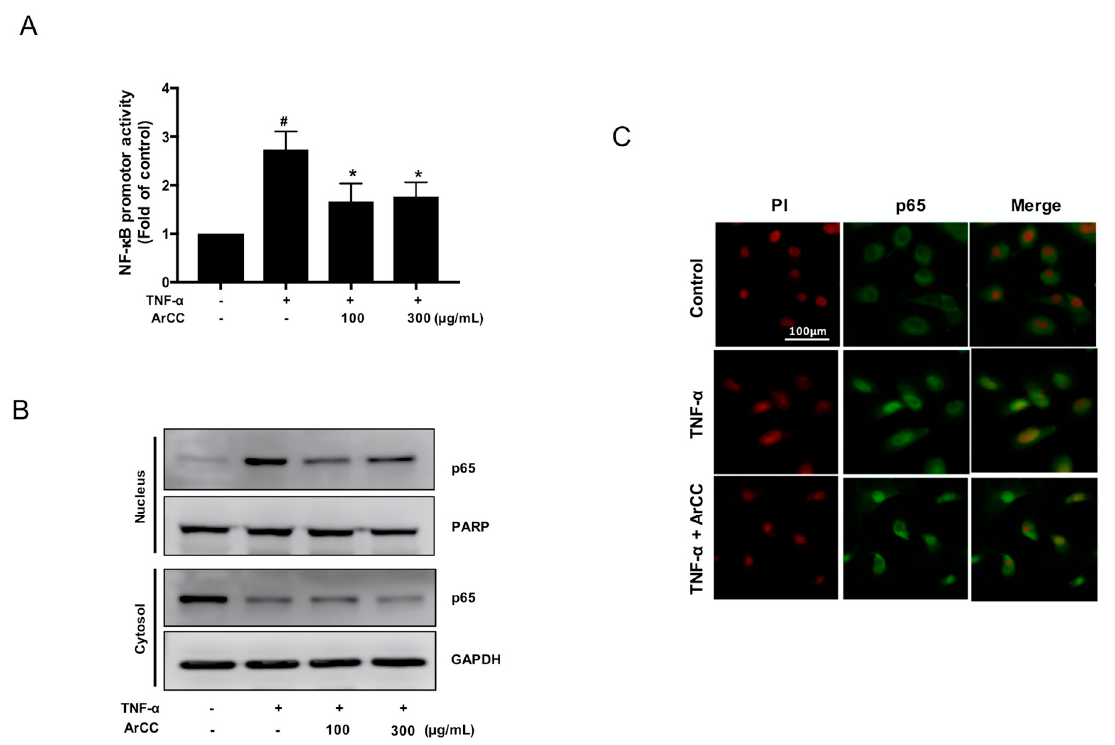
Figure 3. ArCC treatment significantly inhibited TNF- α -induced nuclear factor- κ B (NF- κ B) activity with translocation of NF- κ B from the nucleus to the cytosol. ( A ) Transcriptional activity of NF- κ B in TNF- α -stimulated HUVECs following treatment with 100 or 300 µ g/mL of ArCC for 6 h as determined by luciferase reporter gene assay. Data are mean ± SE ( n = 3). * Significantly different ( p < 0.05) compared with TNF- α -only, # p < 0.05 compared with control by one-way ANOVA followed by Bonferroni’s test. ( B ) Immunoblotting for p65 NF- κ B using nuclear fraction prepared from TNF- α -stimulated HUVECs following treatment with 100 or 300 µ g/mL of ArCC for 6 h. The blot was stripped and re-probed with anti-poly (ADP-ribose) polymerase (PARP) antibody and anti-glyceraldehyde 3-phosphate dehydrogenase (GAPDH) to ensure equal protein loading without cross-contamination of the nuclear and cytoplasmic fractions. ( C ) Immunocytochemical analysis for p65 NF- κ B localization in TNF- α -stimulated HUVECs following 6-h of treatment with 300 µ g/mL of ArCC. Staining for p65 NF- κ B and DNA is indicated by green and red fluorescence, respectively. p65 NF- κ B localization was observed using a fluorescence microscope at 100× magnification